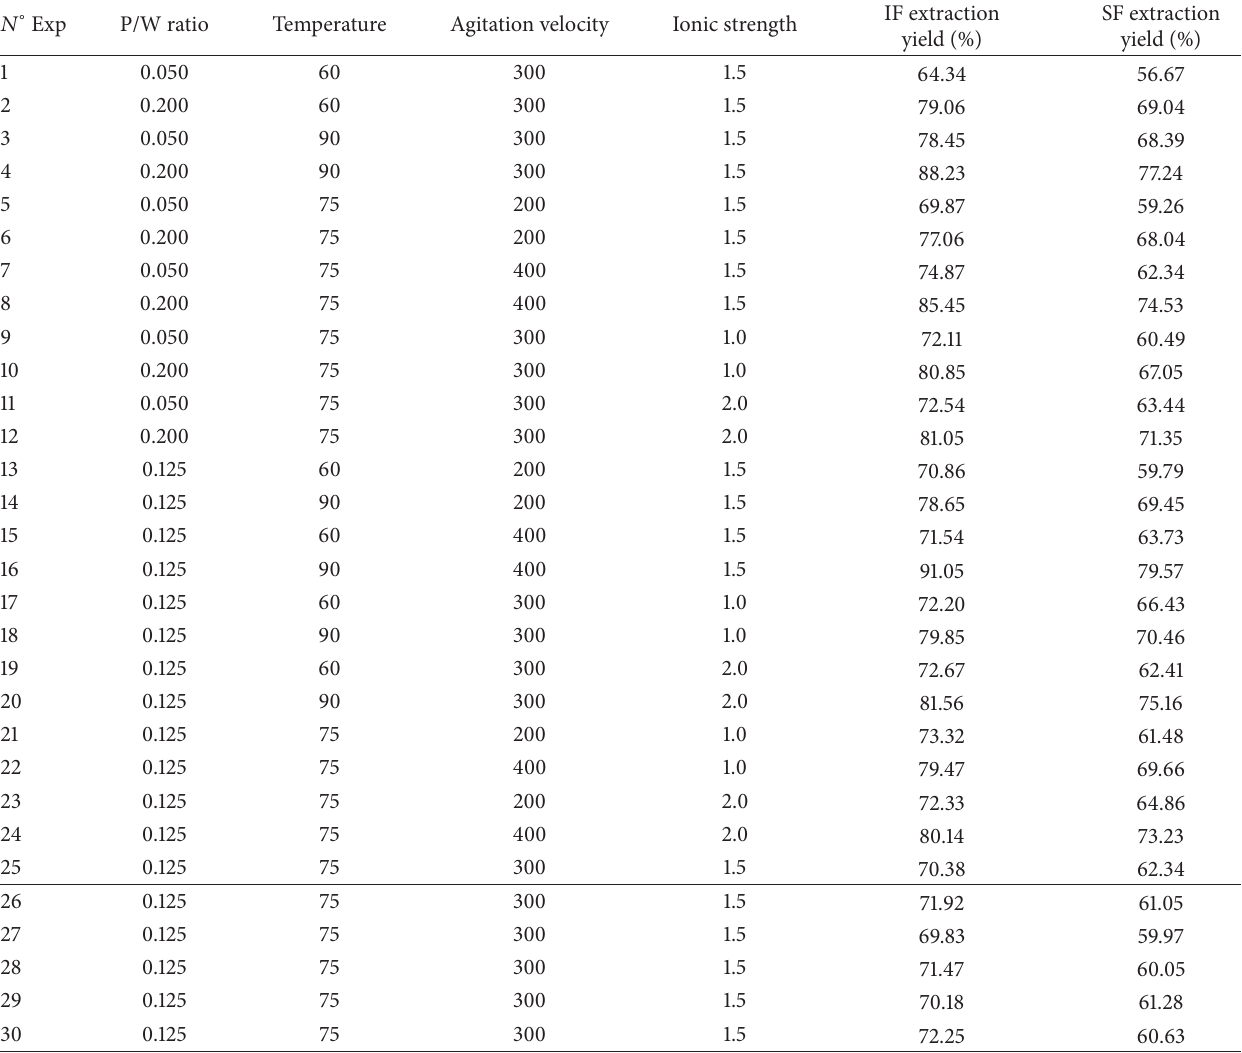
Table 7: Experimental conditions of Box-Behnken design and the corresponding experimental